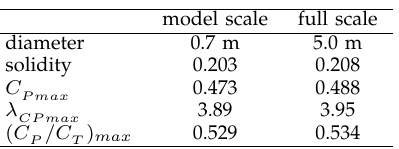
TABLE V F ULL - SCALE AND MODEL - SCALE TURBINE COMPARED : MAIN GEOMETRY AND PERFORMANCE FIGURES .